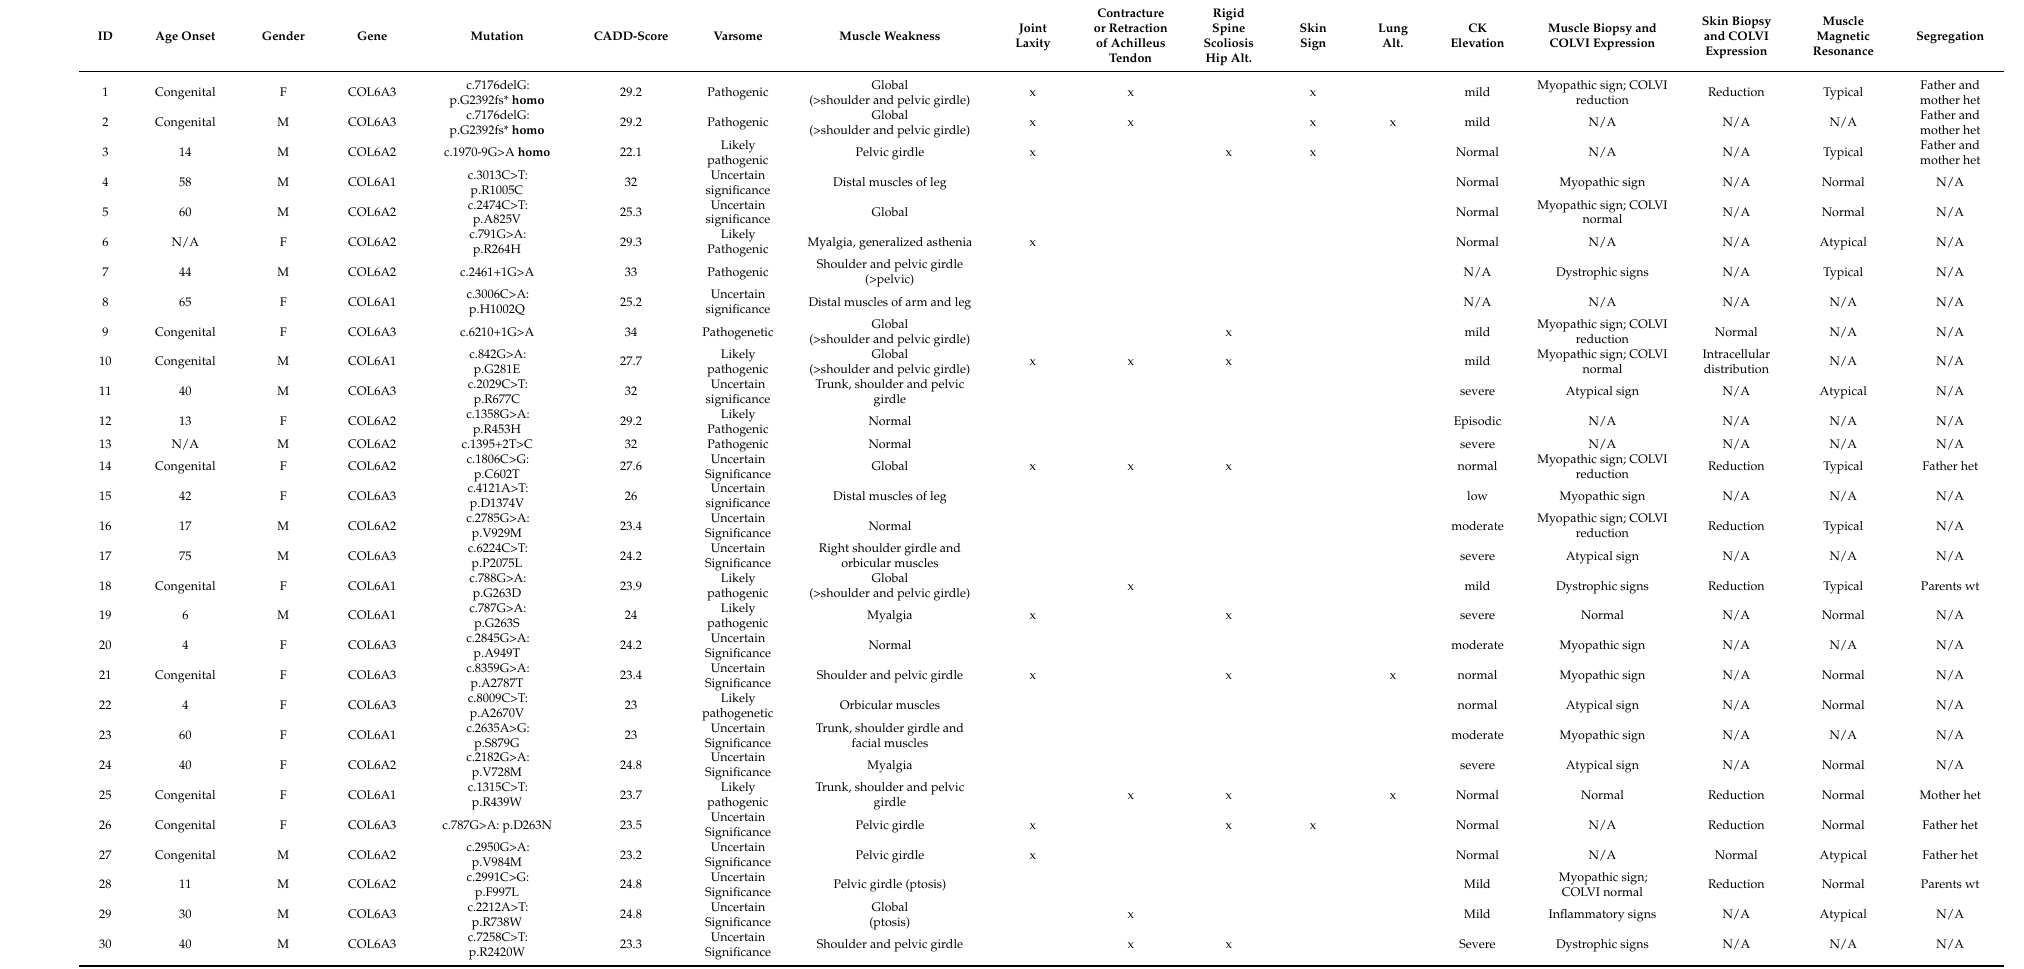
Table 1. Description of phenotype and genotype of 30 selected patients (three with homozygous variants and 27 with CADD score variants above 23). Het = heterozygous, wt = wild-type, x=